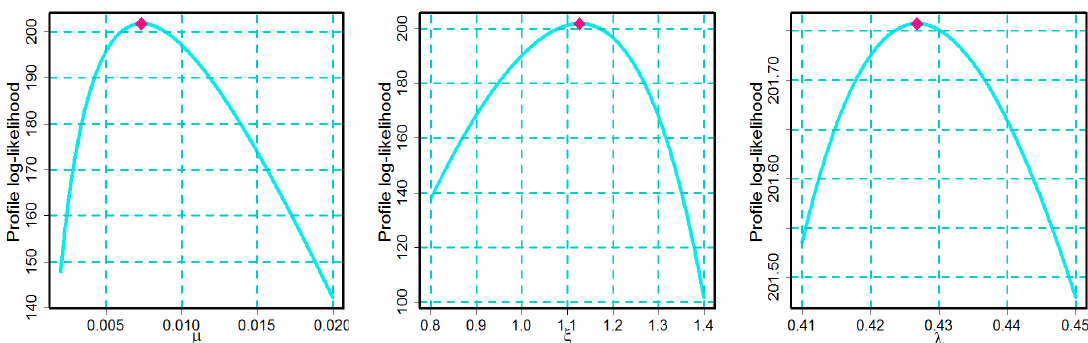
Figure 9. Curves of the profile-likelihood function of three estimated parameters of NIGT-II model for the first real data set.